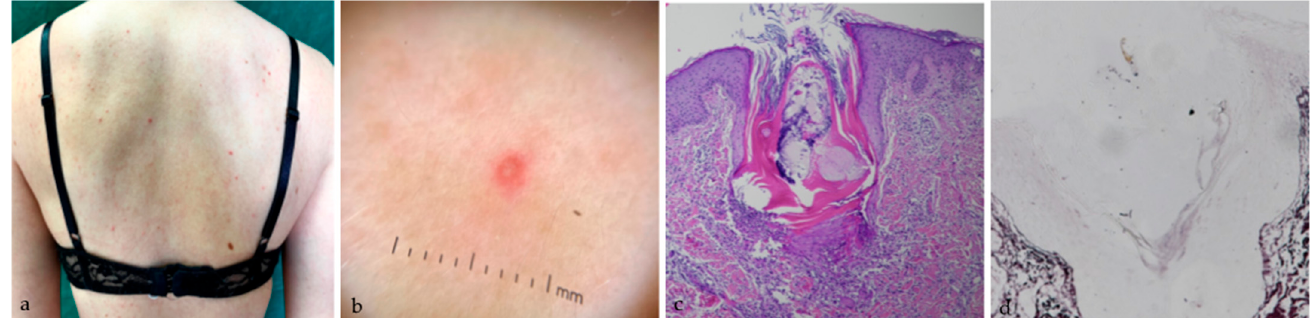
Figure 2. ( a ) Malassezia folliculitis involving the back; ( b ) dermoscopy (10 × ) shows follicular pustule with surrounding erythema; ( c ) H-E stain (20 × ) reveals features of folliculitis with dilatation of the infundibulum and plugging of the follicular ostium with keratin and cellular debris. ( d ) Silver methenamine stain (20 × ) highlights a ruptured follicle containing numerous Malassezia